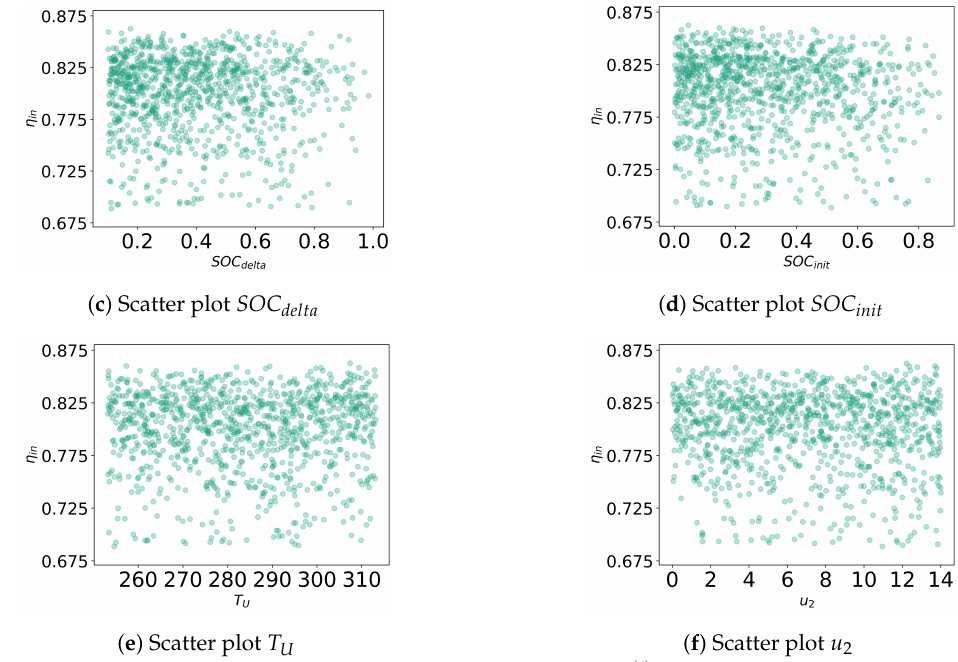
Figure A1. Scatter plots for raw data showing different features x ( j ) and charging state efficiency η in .